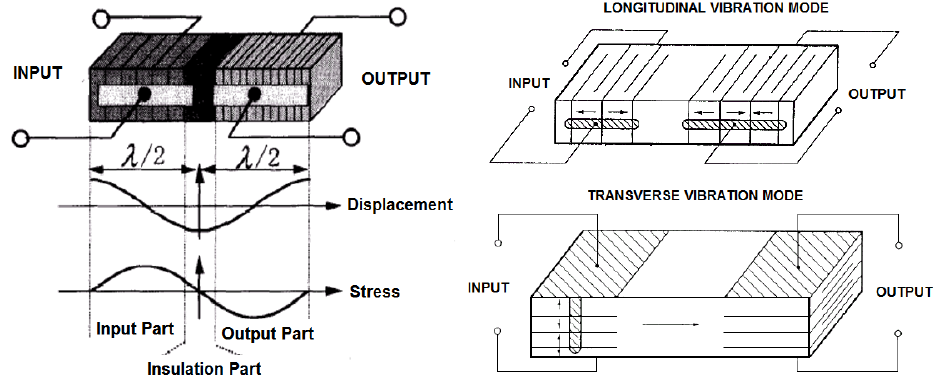
Figure 14. Piezoelectric transformer using longitudinal and transverse mode vibration [72].